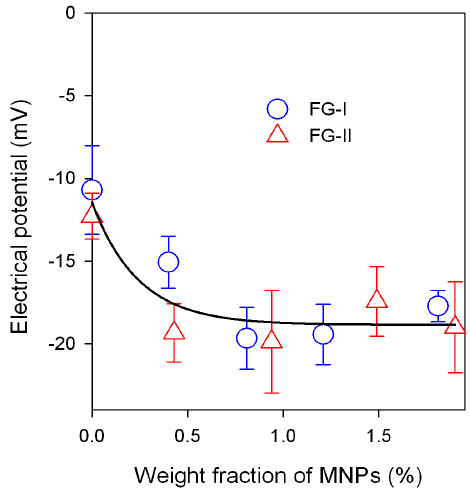
Figure 5. Dependence of the electrical potential of a ferrogel on the weight fraction of MNPs in FG-I and FG-II series. The line is for an eye-guide only.